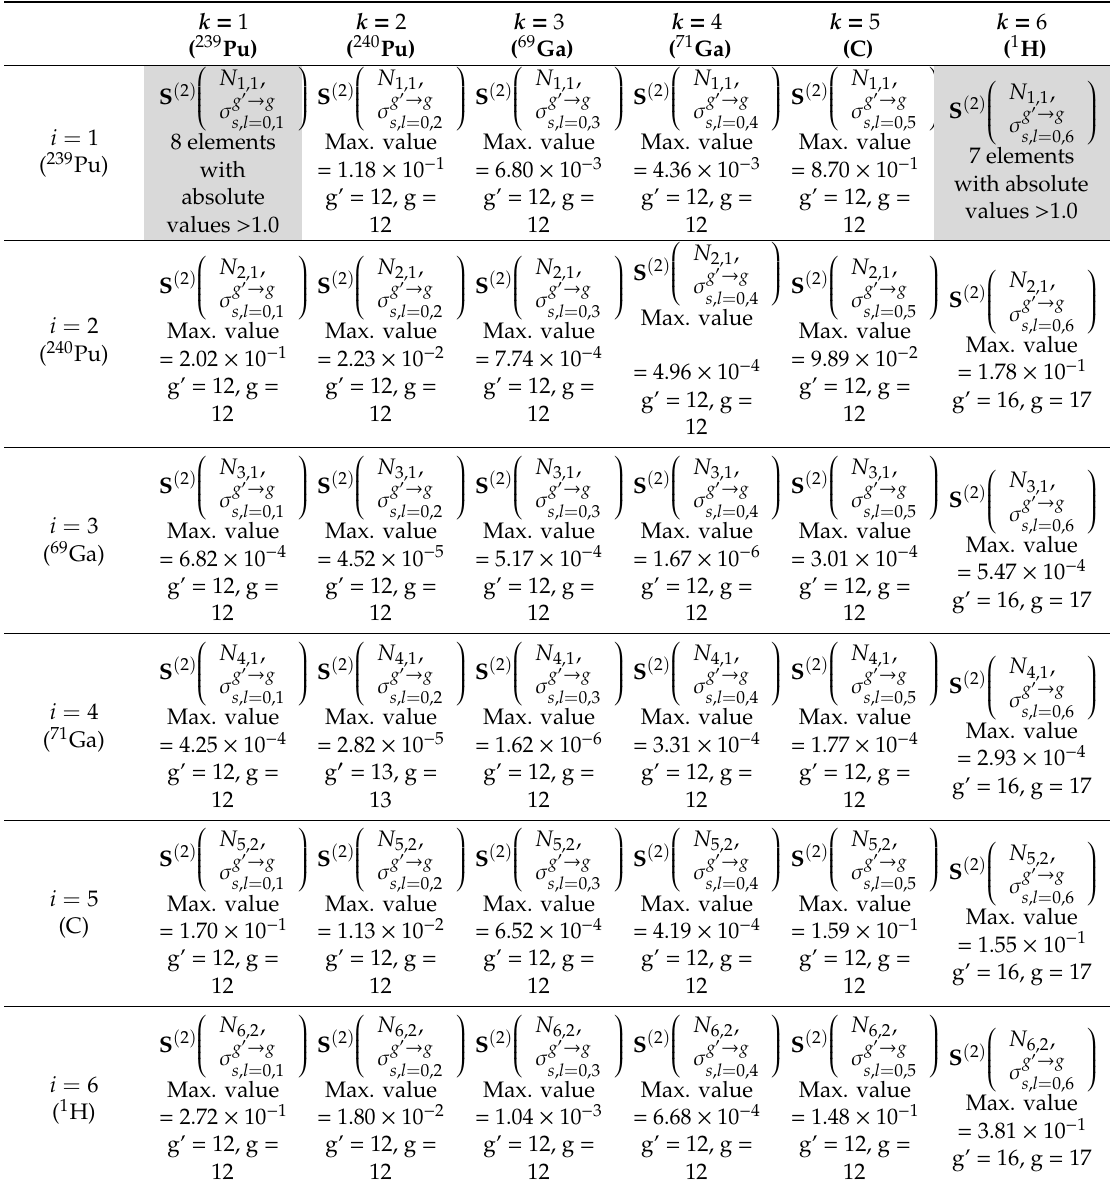
Table 12. Summary presentation of the matrix S ( 2 ) the leakage response with respect to the isotopic number densities and the 0th-order ( l = 0 ) scattering cross sections for all